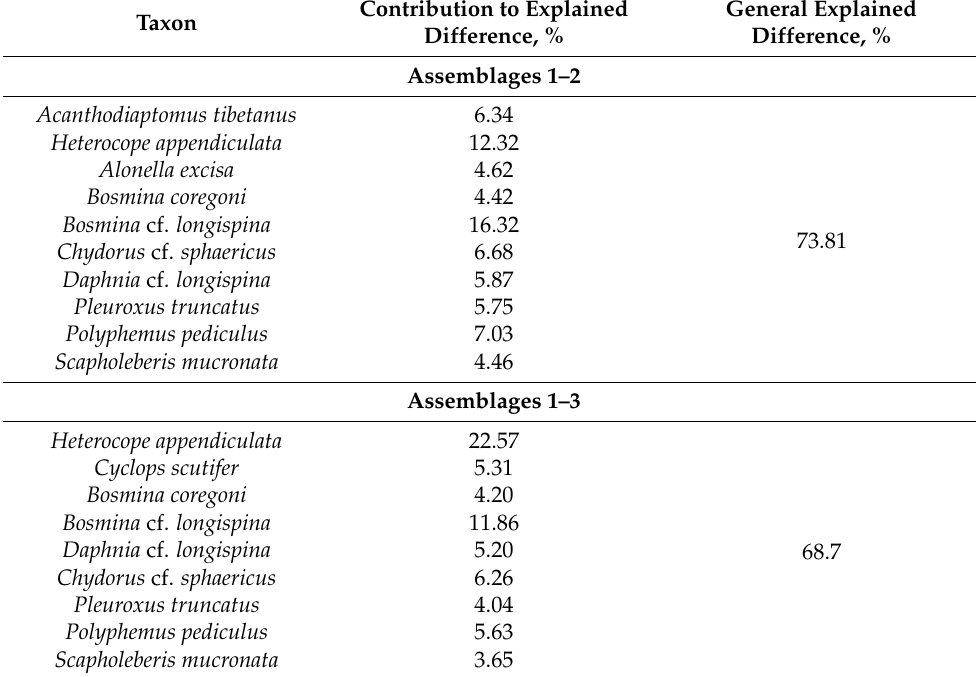
Table 4. Differentiating species of planktonic crustacean assemblages from waterbodies with different area size (meaning of assemblage numbers in Table